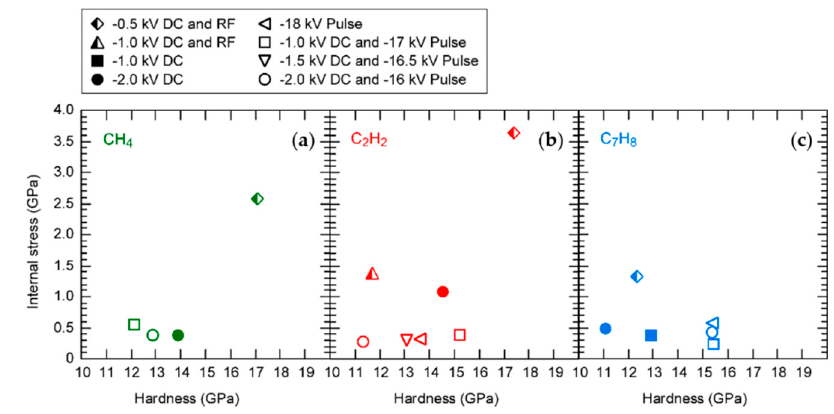
Figure 5. Hardness and internal stress of the samples, for each precursor gas. ( a ) CH 4 ; ( b ) C 2 H 2 ; ( c ) C 7 H 8 . The preparation conditions are indicated by different symbols as listed in the label on top.